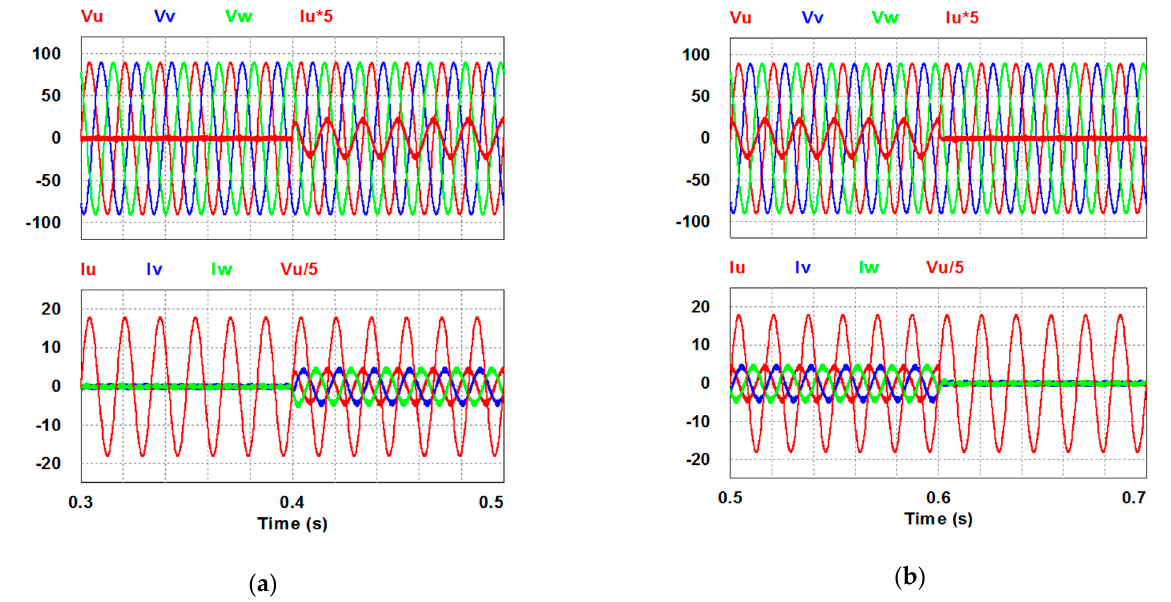
Figure 19. Detailed views of Figure 18: ( a ) from 0.3 to 0.5 s; ( b ) from 0.5 to 0.7 s.